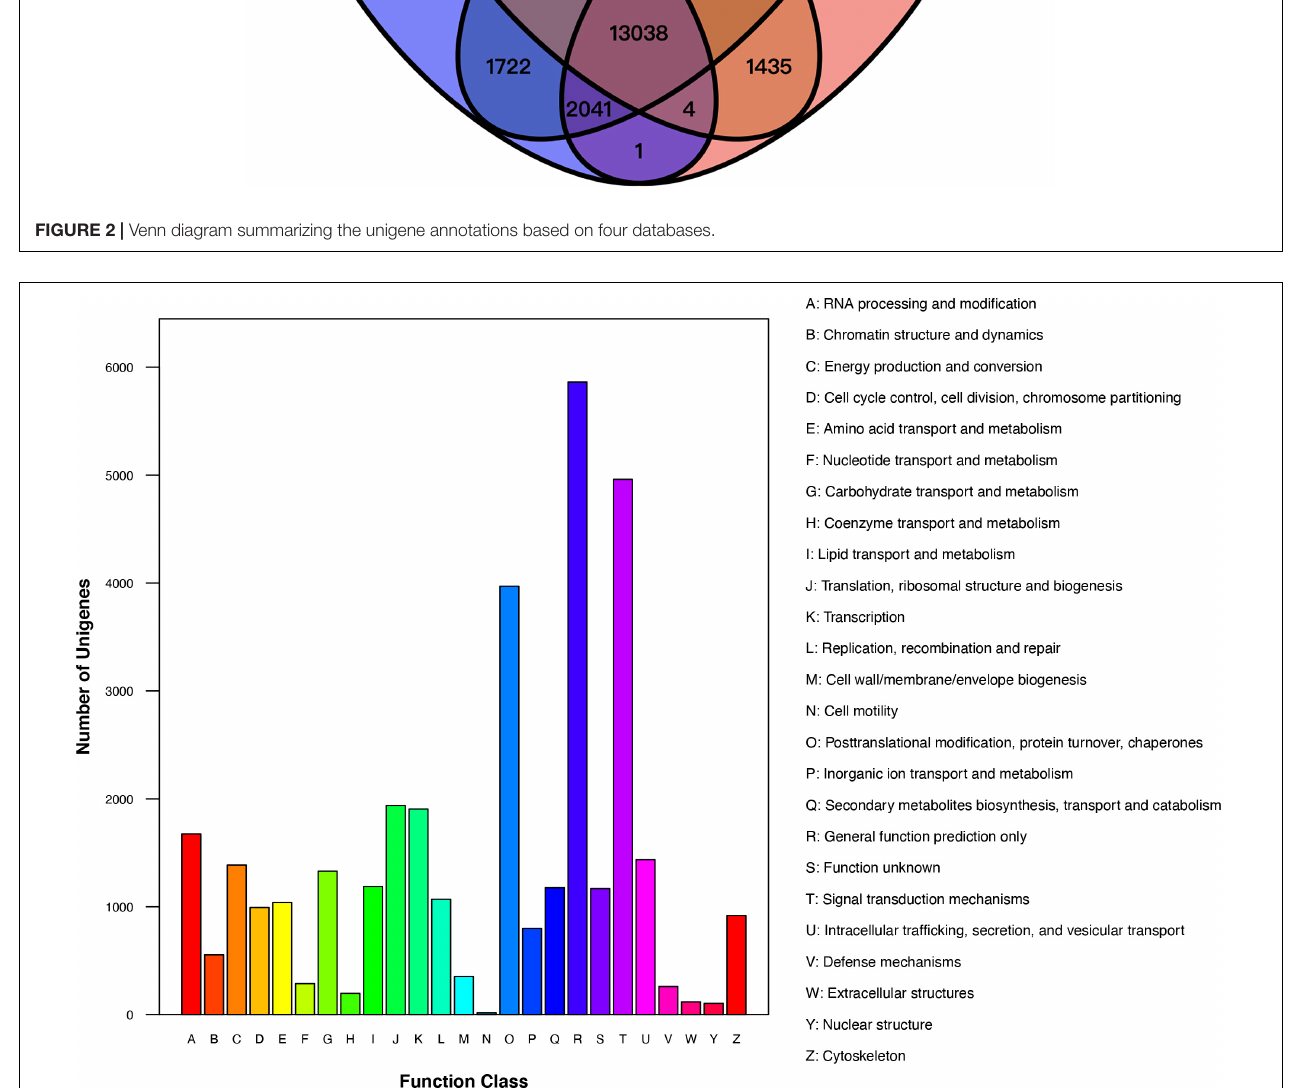
FIGURE 3 | KOG functional classification of Chrysanthemum dichrum unigenes.